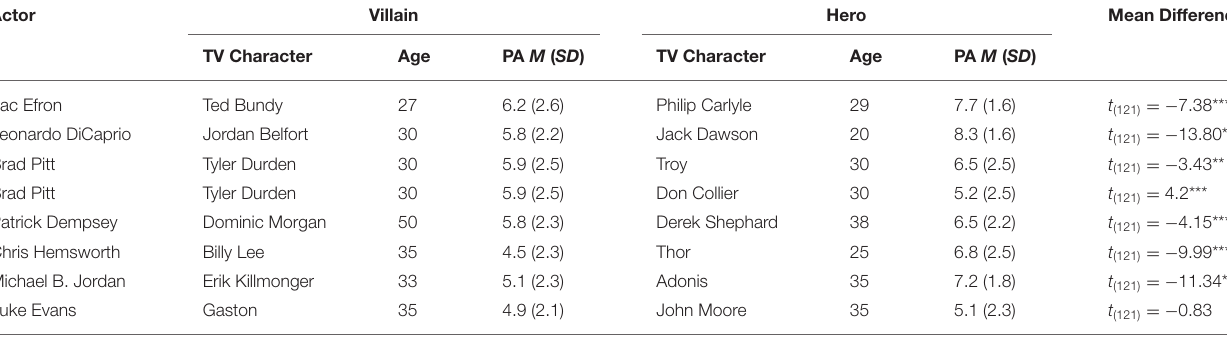
TABLE 2 | Physical appearance of TV characters (same actor) in Study 1 (Pilot Study). Actor Villain Hero Mean Differences TV Character Age